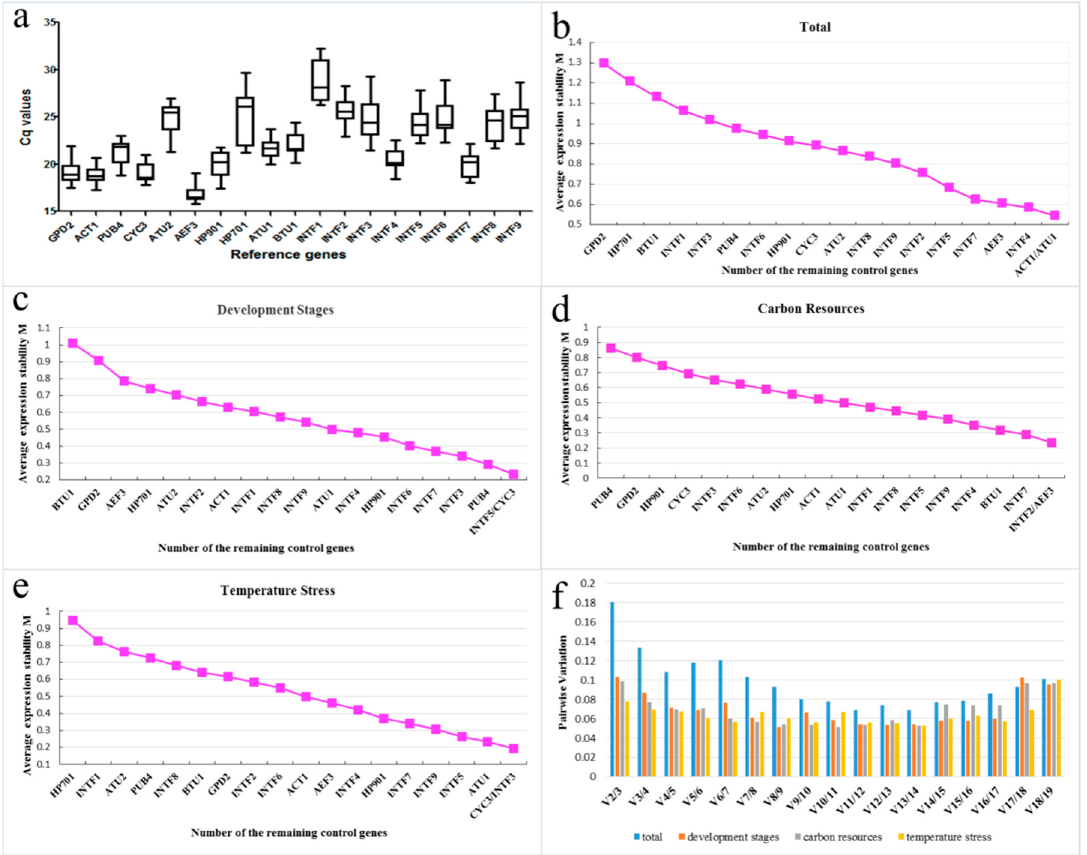
Figure 1 . Expression stability analysis of the candidate reference genes in Morchella importuna. ( a ), Box plot graphs represent Cq values obtained from amplification curves. ( b – e ), expression stability values(M) calculated by geNorm; a lower M value indicates the most stable expression. ( b ), total datasets; ( c ), development stages; ( d ), carbon sources; ( e ), temperature stress. ( f ), pairwise variation (V) for the optimal number of reference genes in an accurate normalization. The pairwise variation (Vn/Vn+1) was analyzed between the normalization factors NFn and NFn+1 by geNorm.